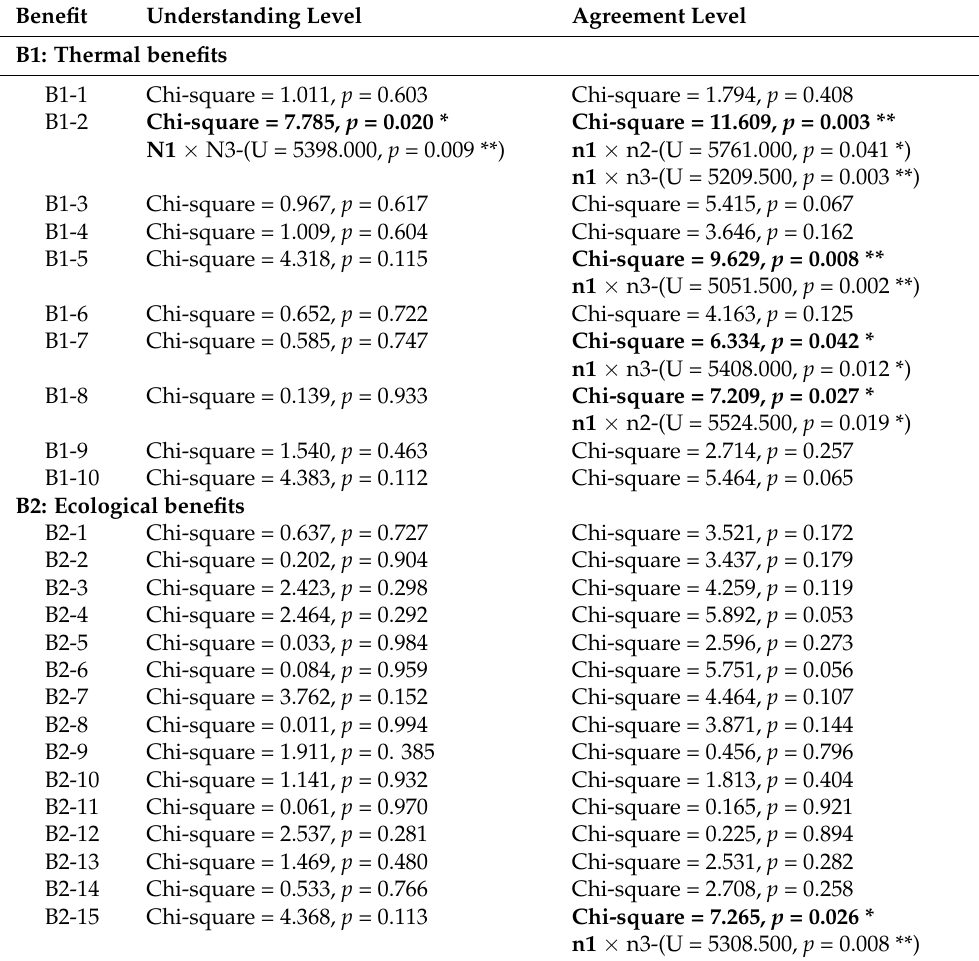
Table 6. Impacts of current living environments on respondents’ perceptions of UGS ecological benefits a